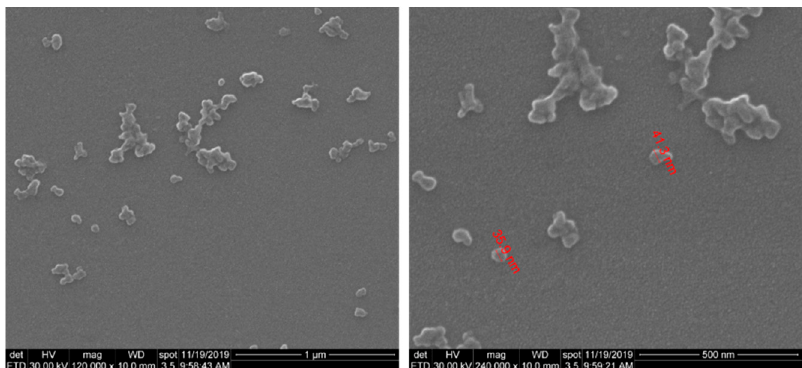
Figure 1. SEM microphotographs of SF/PEG nanoparticles.